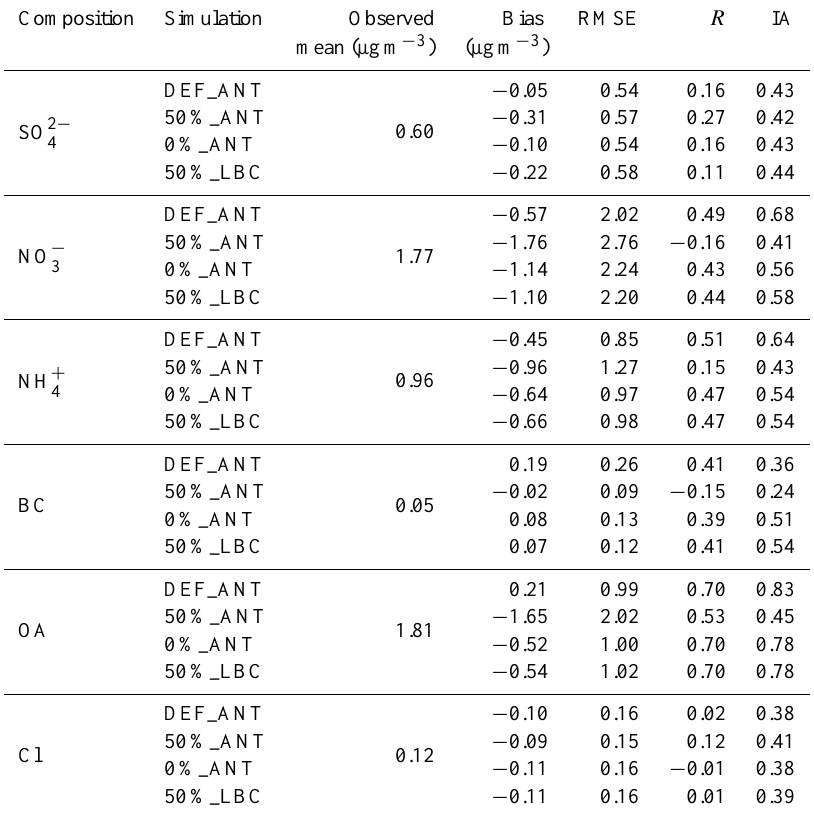
Table 13. Performance of simulated aerosol composition over all the CIRPAS Twin Otter flights in terms of bias, root-mean-square error (RMSE), correlation coefficient ( R ), and index of agreement